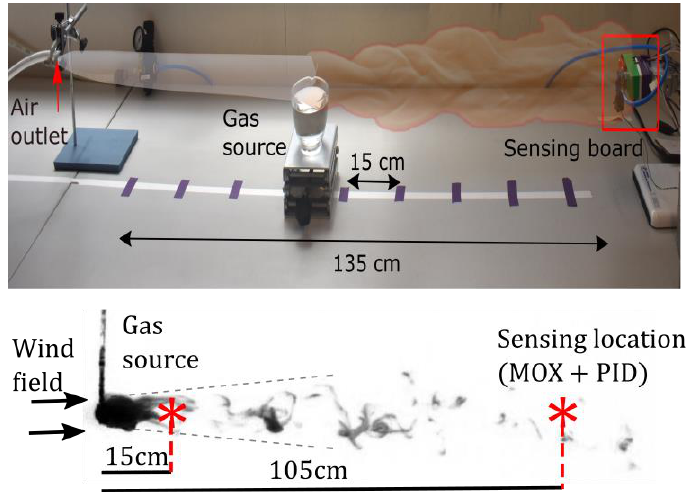
Figure 7. Generation of ethanol plumes in an open environment. The test bench uses a pressurized air outlet (6.3 mm radius, 20 L/min) and a vessel (5 cm radius) filled with 200 mL of ethanol (gas source). The sensing board, which consists of MOX sensors and a fast PID, was placed at 15 cm and 105 cm from the gas source.